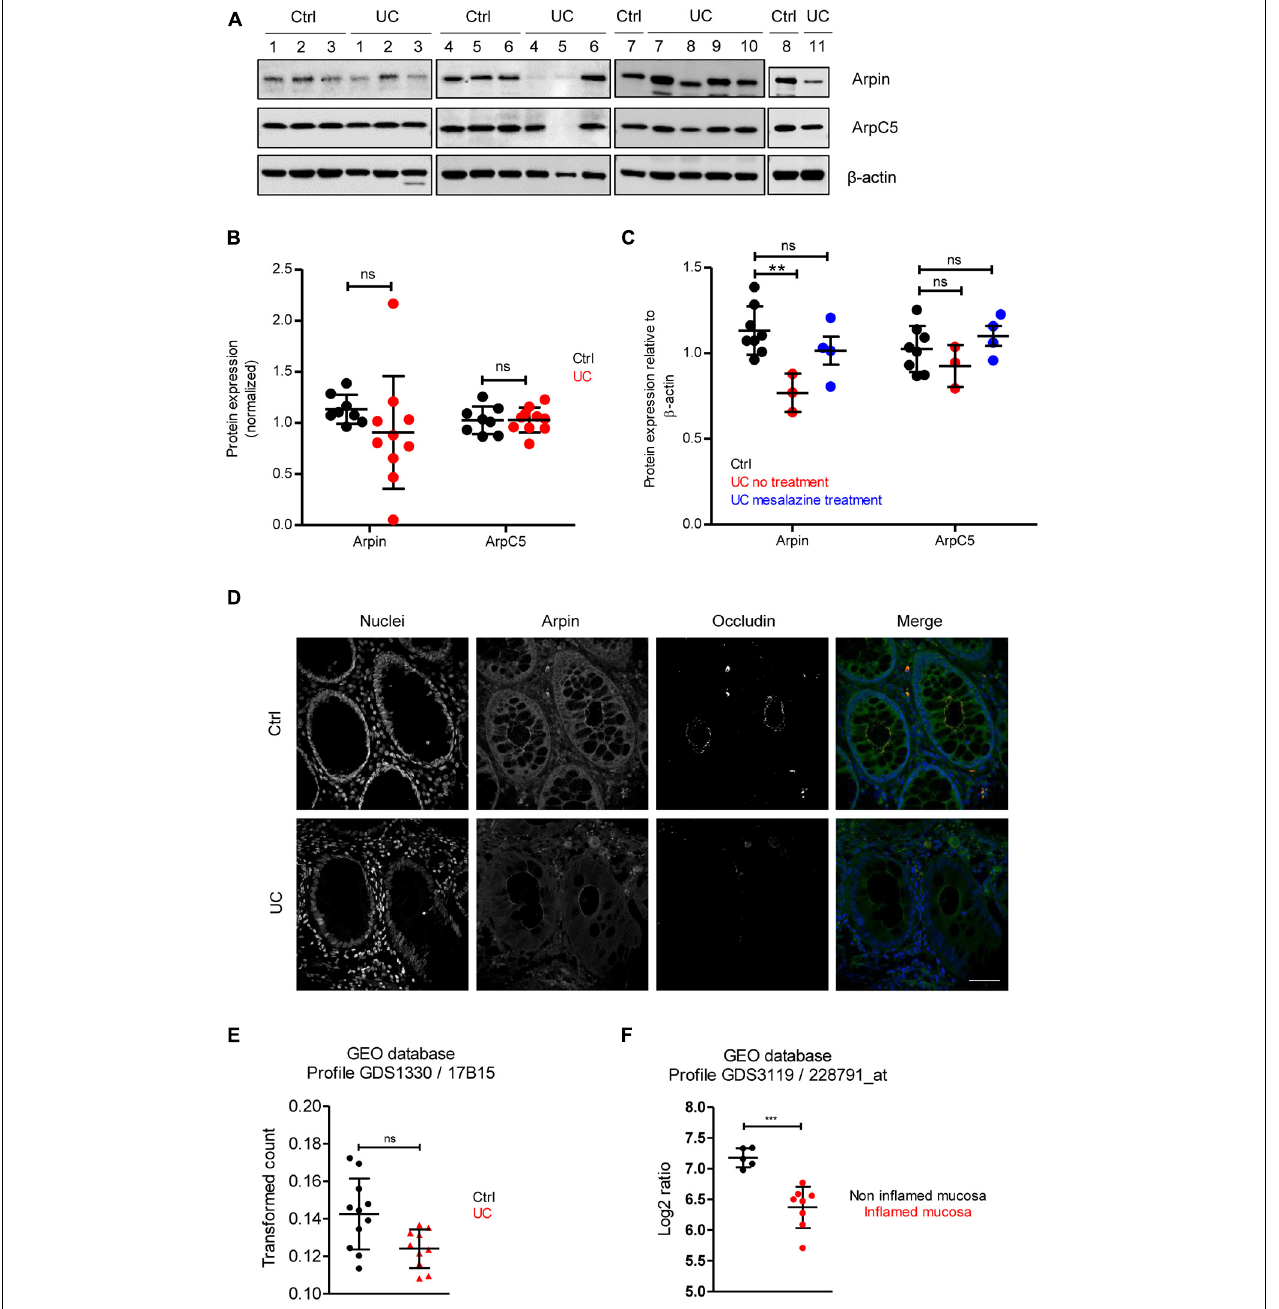
FIGURE 4 | Arpin is downregulated in inflamed areas of colon tissue from ulcerative colitis (UC) patients. (A) Western blot for arpin and ArpC5 from resection specimens of patients with UC and non-inflamed controls. β -actin was probed as the loading control. (B) Quantification of pixel intensities including all bands (compare Table 1 for single values; nCtrl = 8, nUC = 10; two-tailed t -test followed by Mann–Whitney test; ns, non-significant. We only excluded sample UC 5 as a technical outlier because of the absence of both arpin and ArpC5 and a much weaker β -actin band. (C) Comparison of pixel intensities from bands of control samples, samples from patients receiving no treatment, and patients receiving mesalazine in their medication regimen. ** p < 0.01. (D) Representative immunostaining for occludin and arpin from resection specimens of patients with histologically active UC and non-inflamed controls; n = 3. Bar = 20 µ m. (E) Arpin mRNA analysis in biopsies from UC patients compared to controls (n: Control = 11, UC = 10; one-way ANOVA with Kruskal–Wallis correction. (F) mRNA analysis of arpin from publicly available datasets (n: non-inflamed mucosa = 5, inflamed mucosa = 8; two-tailed t -test with Welch’s correction). *** p < 0.001. ns = not significant.